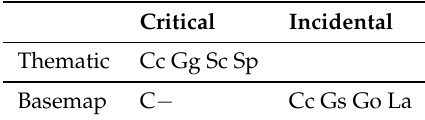
Table 8. Schedule of operators for Beccario’s